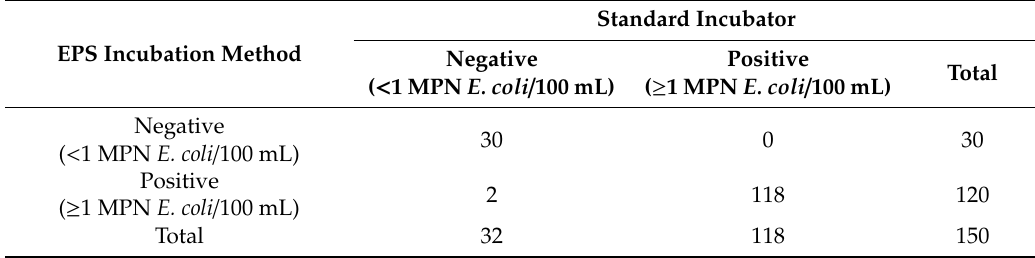
Table 4. Summary of occurrences of false negative and false positive